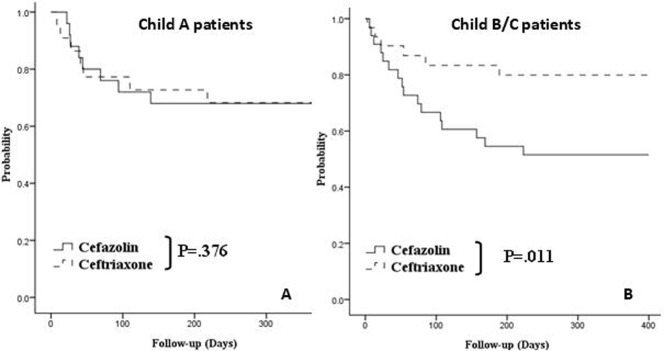
Actuarial probability of remaining free of rebleeding at different clinical stages of cirrhotic patients.There was a similar probability of remaining free of rebleeding between patients who were prescribed with intravenous ceftriaxone and those prescribed with cefazolin in Child’s A group (p = 0.376 by log-rank test) (A). A significantly higher probability of remaining free of rebleeding was observed in those who were prescribed with intravenous cefazolin than in those given ceftriaxone in Child’s B and C group (p = 0.011) (B).